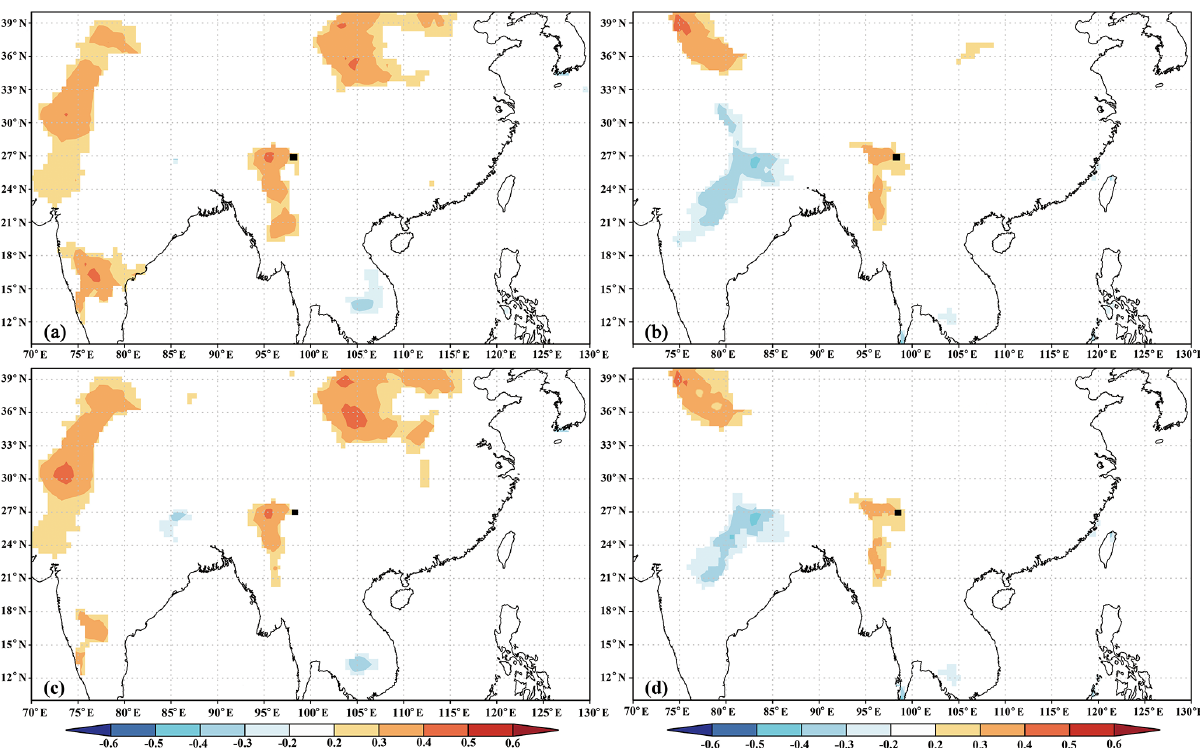
Figure 8. Spatial correlations of actual ( a raw data; c first-differenced data) and reconstructed ( b raw data; d first-differenced data) NGS precipitation with a gridded dataset of the NGS precipitation (average from November of the previous year to February of the current year) during their overlapping periods (1956–2005). The black square indicates the location of the study